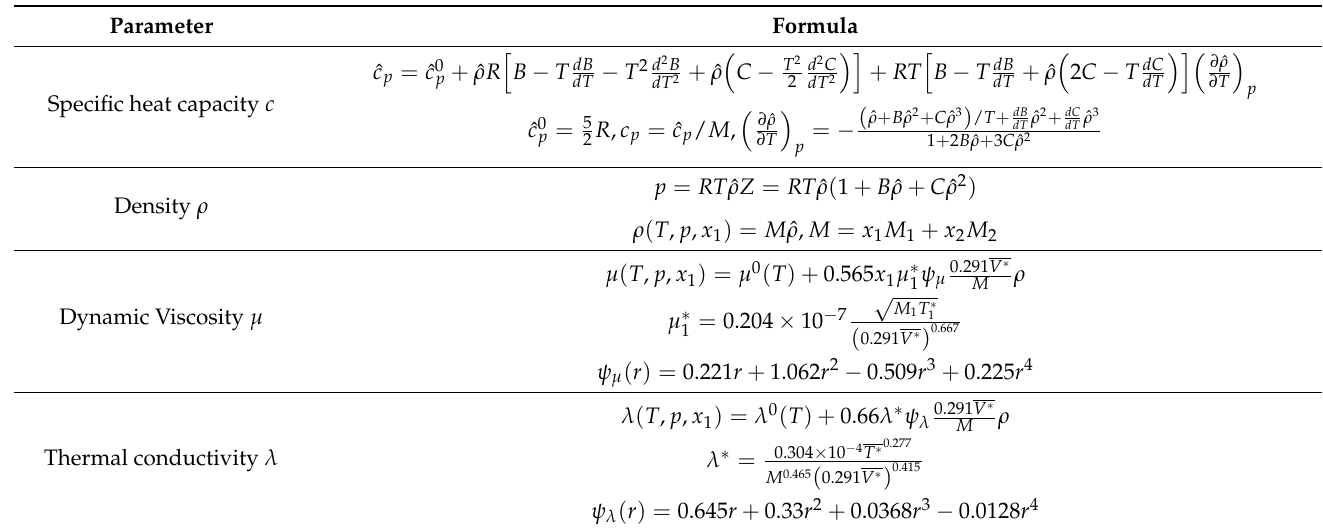
Table 1. The semi-empirical formula for calculating the physical property parameters of binary mixture rare gases proposed by Tournier et al.